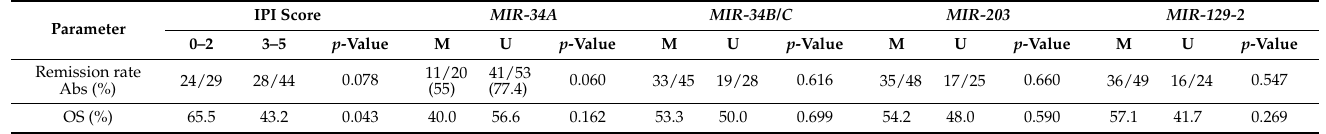
Table 5. The indicators of therapy effectiveness in the group of DLBCL